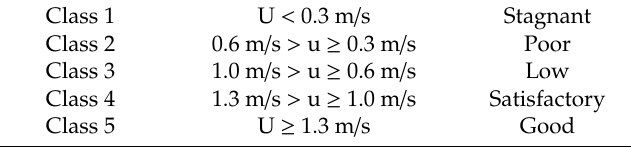
Table 6. Classification of pedestrian-level natural ventilation (u) in street canyons